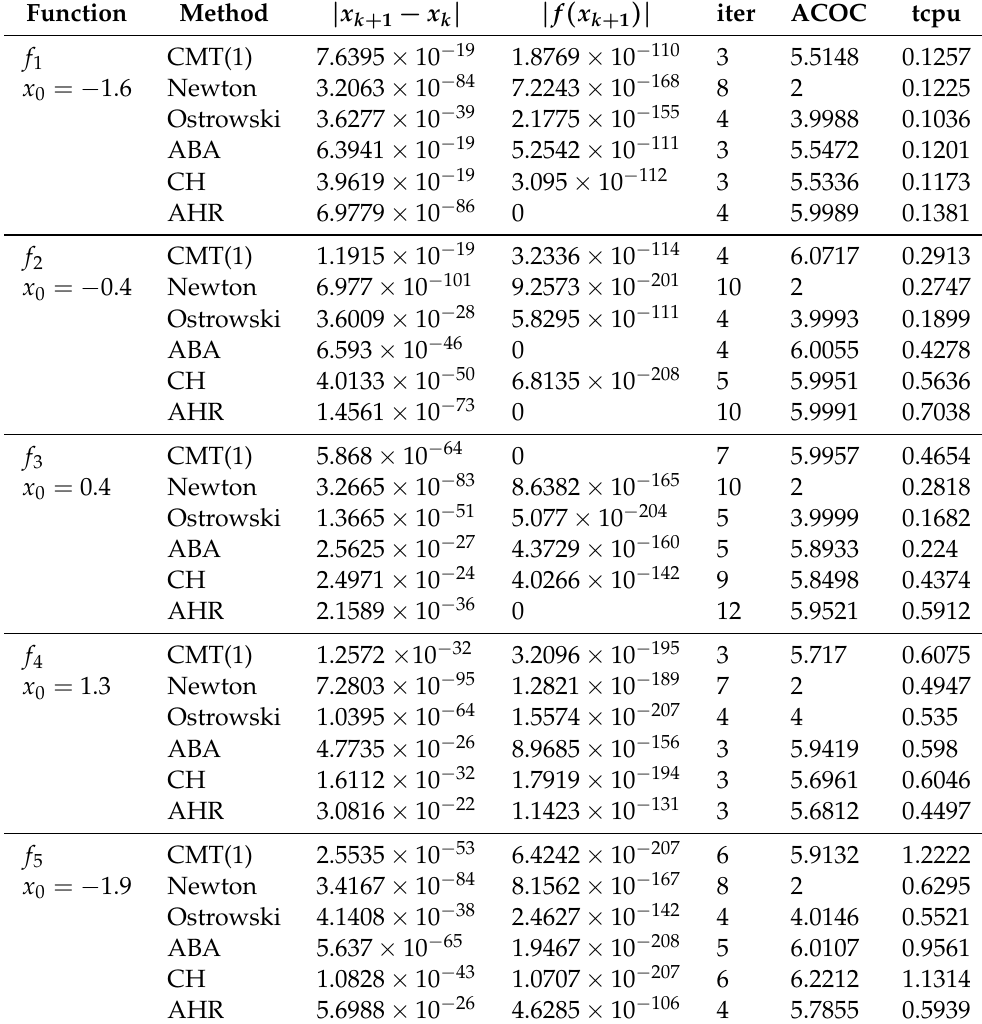
Table 1. Numerical performance of iterative methods in nonlinear equations for x 0 close to ξ .